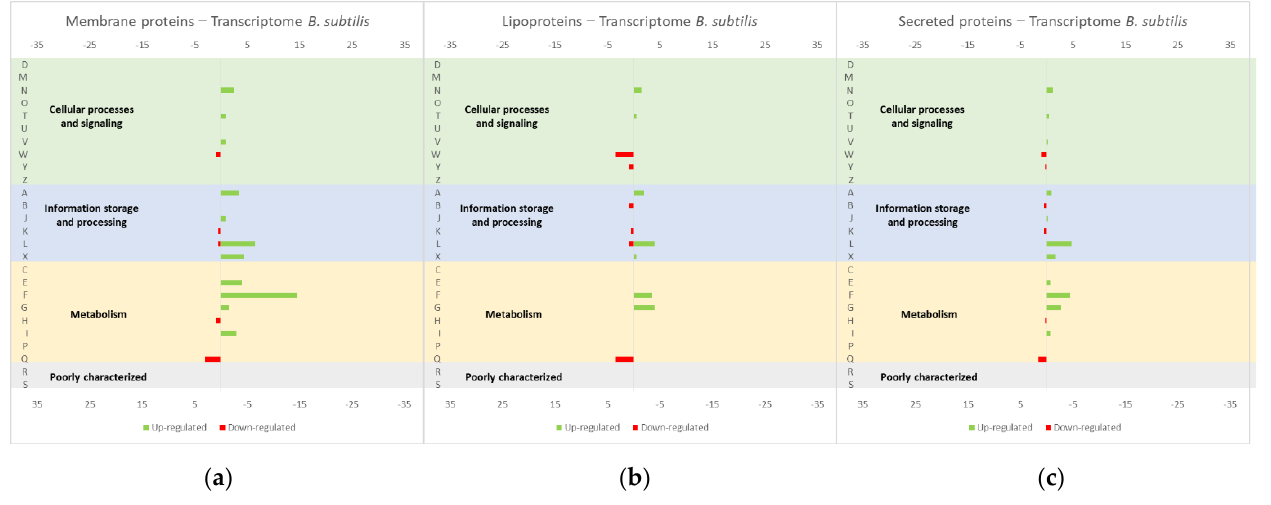
Figure 8. Effect of the overproduction of ( a ) membrane proteins, ( b ) lipoproteins and ( c ) secreted proteins, both endogenous and heterologous, in the B. subtilis transcriptome profile. The graphs were constructed with compiled data from Marciniak et al. [50] and represent the total number of transcripts up or down-regulated in each cellular process. The letters on the yy axis correspond to the following COG categories: A, RNA processing and modification (not used for prokaryotic COGs), B, chromatin structure and dynamics, C, energy production and conversion, D, cell cycle control and mitosis, E, amino acid metabolism and transport, F, nucleotide metabolism and transport, G, carbohydrate metabolism and transport, H, coenzyme metabolism, I, lipid metabolism, J, translation, K, transcription, L, replication and repair, M, cell wall/membrane/envelope biogenesis, N, Cell motility, O, post-translational modification, protein turnover, chaperone functions, P, Inorganic ion transport and metabolism, Q, secondary metabolites biosynthesis, transport and catabolism, T, signal transduction, U, intracellular trafficking and secretion, Y, nuclear structure (not applicable to prokaryotic COGs), Z, cytoskeleton (not applicable to prokaryotic COGs); R, general functional prediction only (typically, prediction of biochemical activity), S, function unknown [35,36].